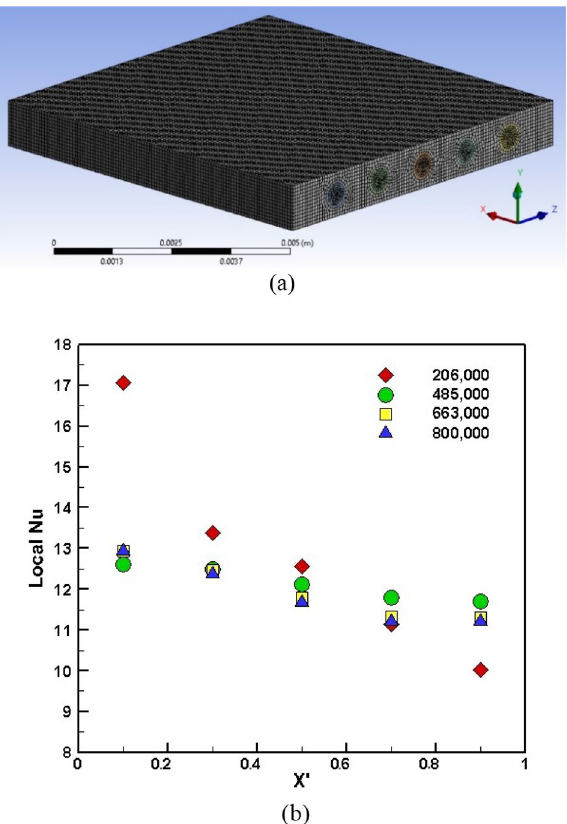
Figure 2. ( a ) 3D model with mesh in ANSYS meshing VER.18.2, ( b ) Mesh independency of local Nusselt number versus the normalized location of microchannel.